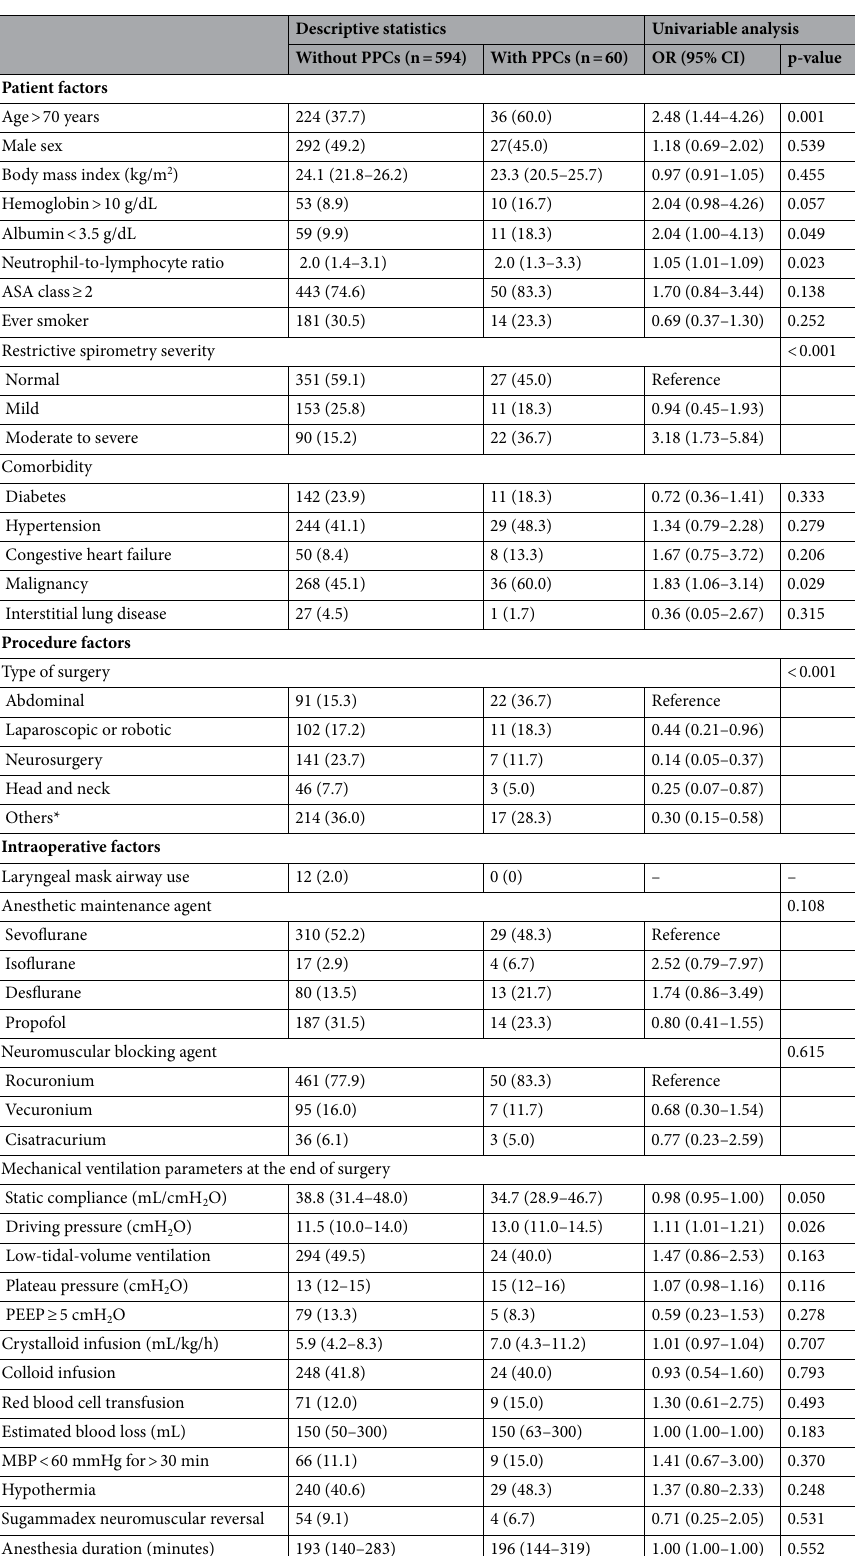
Table 1. Perioperative variables of patients with or without postoperative pulmonary complications (PPCs) in the whole study cohort. Data are presented as median (25th percentile, 75th percentile) or frequency (%). ASA American society of anesthesiologist, MBP mean blood pressure, PEEP positive end-expiratory pressure. *Others included breast, endocrine, vascular, orthopedic and spinal, gynecologic, urologic, ophthalmologic, and plastic